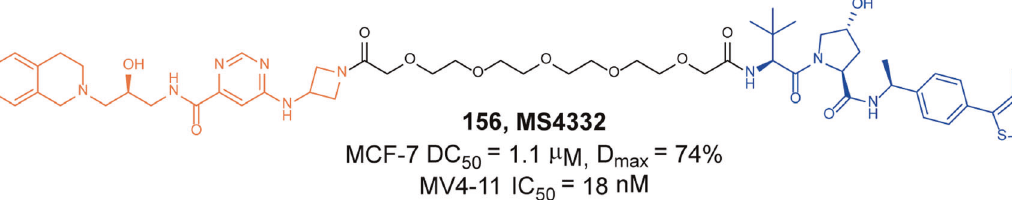
Fig. 38 The representative PROTAC targeting